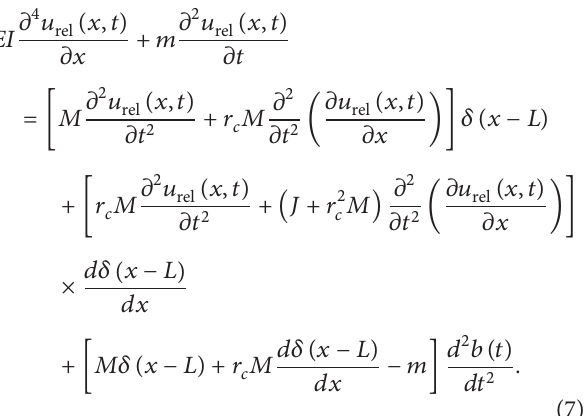
Figure 3: The simplified model of cantilever with tip-mass being equated by inertial force and